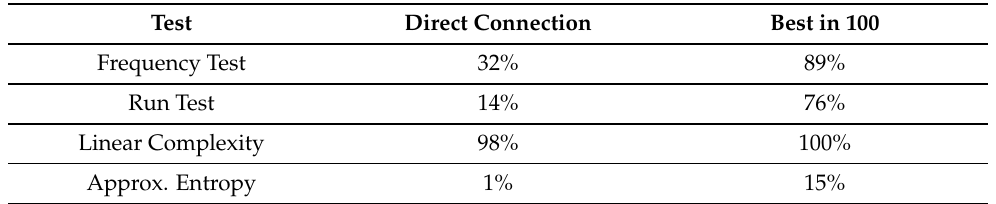
Table 7. Success ratio of passing a National Institute of Standards and Technology (NIST) test for 100 IPN instances with two 32-bit homogenous nodes. The maximum number of configurations allowed for each IPN is 100, each configuration collects 10,000-bit result. Test Direct Connection Best in 100 Frequency Test 32% 89% Run Test 14% 76% Linear Complexity 98% 100% Approx. Entropy 1%